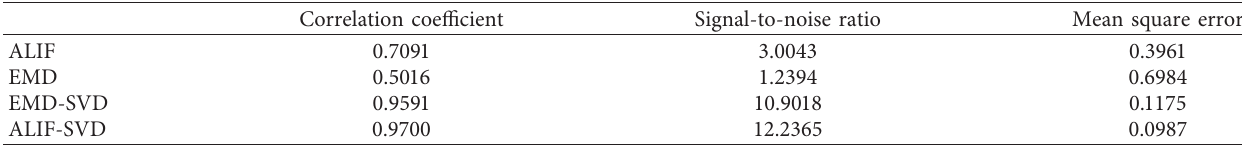
Table 1: Related index values. Correlation coefficient Signal-to-noise ratio